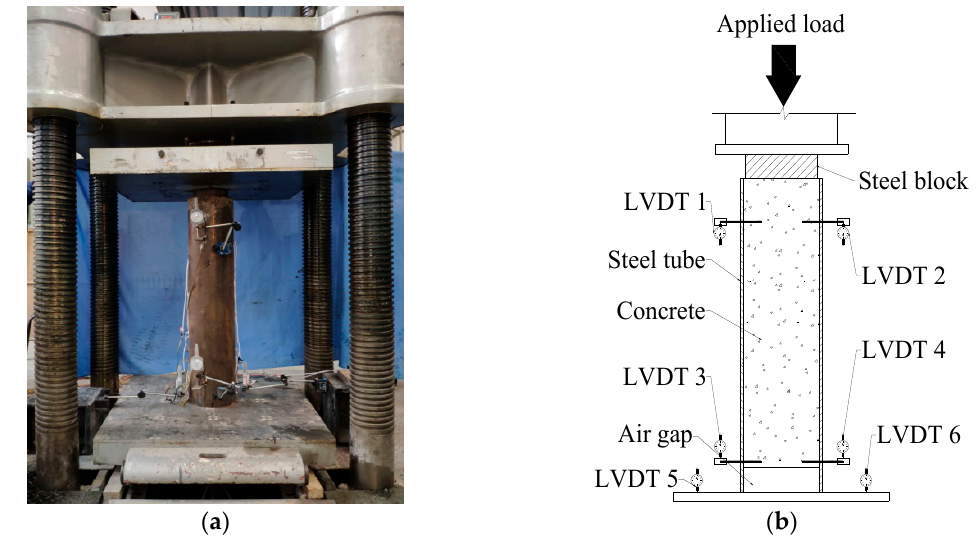
Figure 3. Experimental apparatus. ( a ) Test setup; ( b ) Placement of LVDTs.